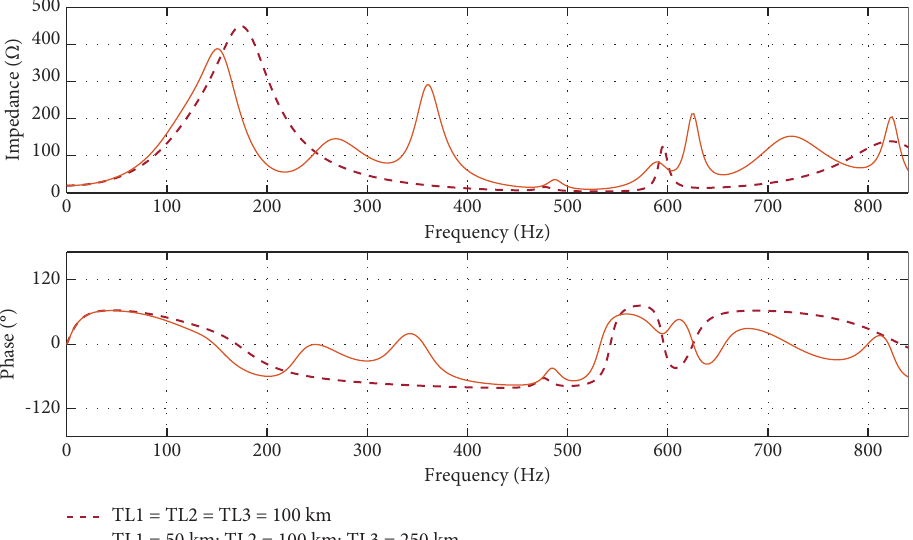
Figure 4: Impedance measurement at busbar